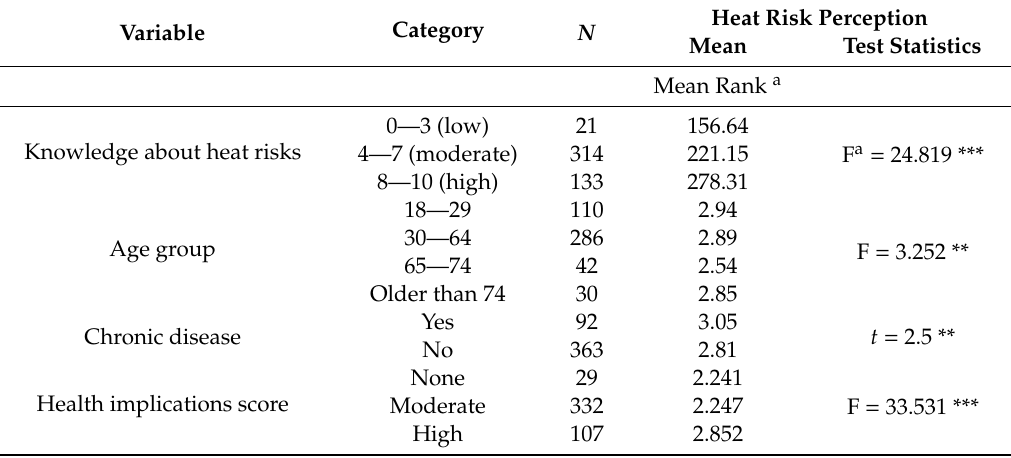
Table 4. Di ff erences in heat risk